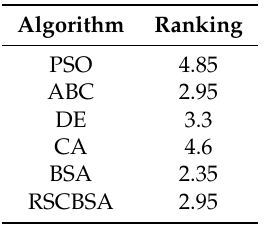
Table 6. Average Rankings of the algorithms (Friedman) on fixed multimodal benchmark